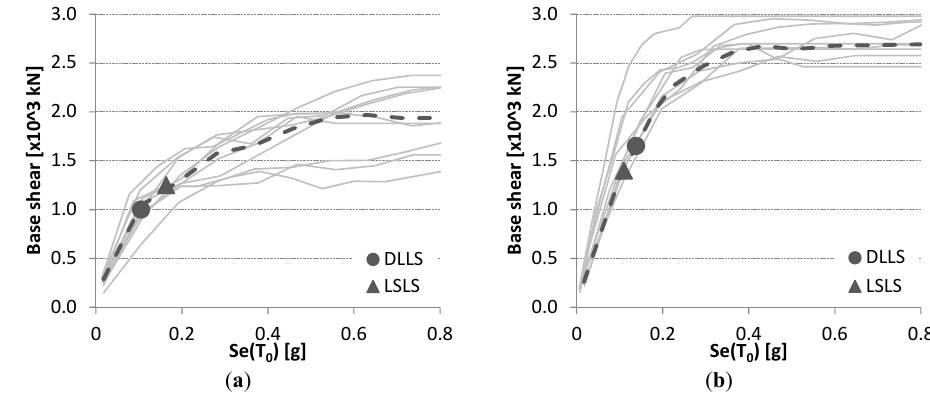
Figure 6. Spectral pseudo-acceleration vs. maximum base shear curves obtained for X ( a ) and Y ( b ) direction by considering all Incremental Dynamic Analysis (IDA) analysis (solid line) and median values (dashed line).